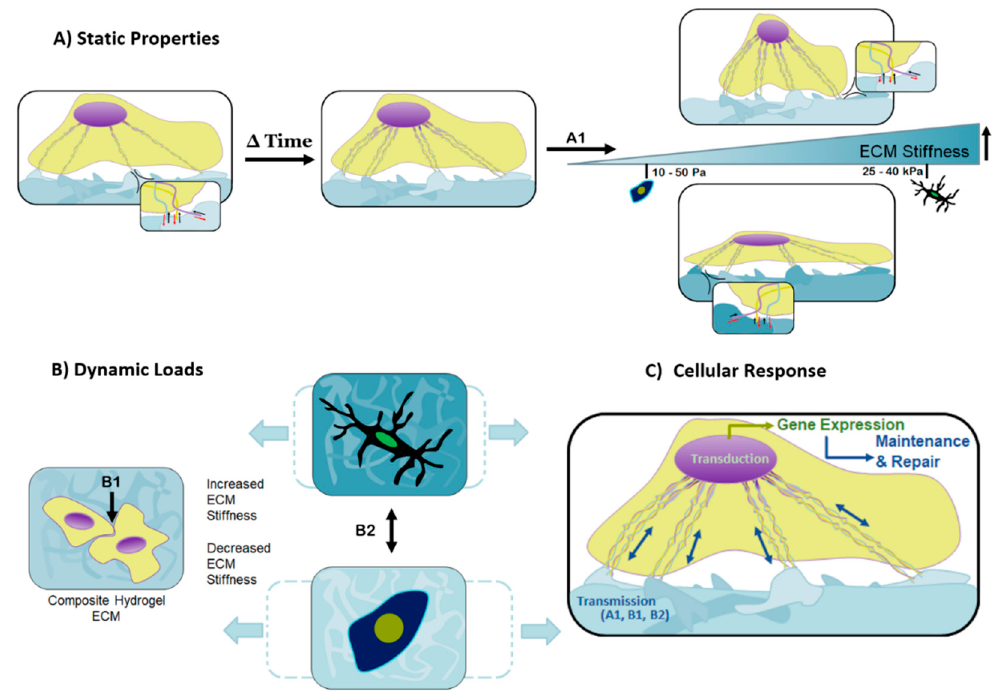
Figure 3. Cellular behavior is affected by a multitude of studied contributions, including mechanical cues, static properties, and dynamic loads. ( A ) Responses to the substrates mechanically static properties are controllable by the matrix stiffness and topographical features, equally capable of dictating cell motility, proliferation, and differentiation. Over time, the cell assesses its local environment and improves focal adhesion sites on suitable substrates through the development of its cytoskeleton. The overall stiffness of the matrix determines the coupled forces created by the probing cell and matrix response, represented by A1. The softer the matrix, the more the cell is able to overcome the matrix stiffness and become rounder as the cytoskeleton pulls inward. In contrast, a matrix of increased stiffness causes the cell to spread over the matrix as the cell’s cytoskeleton is unable to pull inward; ( B ) dynamic forces must appropriately be transferred through the composite substrate for healthy cellular function and ultimately normal tissue- and organ-level turnover. The amplitude and frequency of the dynamic loads, paired with the stiffness of the matrix, determine the maximum deformation of the matrix, represented by B2; ( C ) combining the signals the cell detects from the matrix stiffness, A1, the external dynamic forces, B2, and intercellular contact forces, B1, results in a coordinated transmission, and subsequent transduction (gene expression) that leads to tissue maintenance and repair. These tailorable components are responsible for cellular behavior and can be used in the design of composite hydrogels to create material systems targeted toward diverse cell types and tissues.